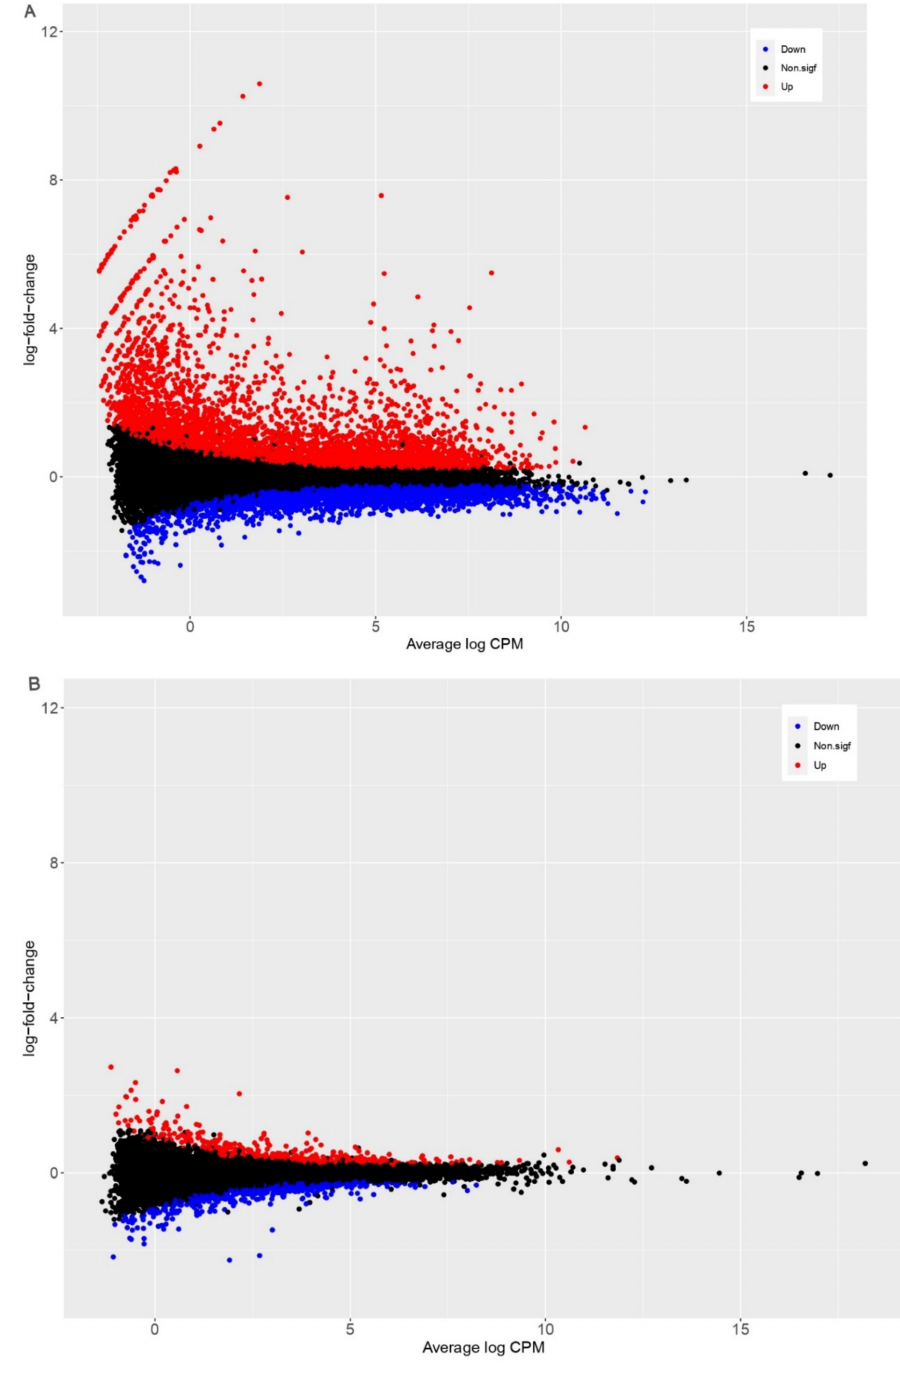
Figure 2. Differentially expressed genes (DEGs) in H. sapiens (human intestinal epithelial cells (HIEC)) ( A ) and S. scrofa (Porcine intestinal epithelial cells (IPEC)) ( B ) at 24 hpi vs non-infected cells. DEGs up-regulated are represented by red dots, DEGs down-regulated are represented by blue dots, and genes with no significant differences in expression are represented by black